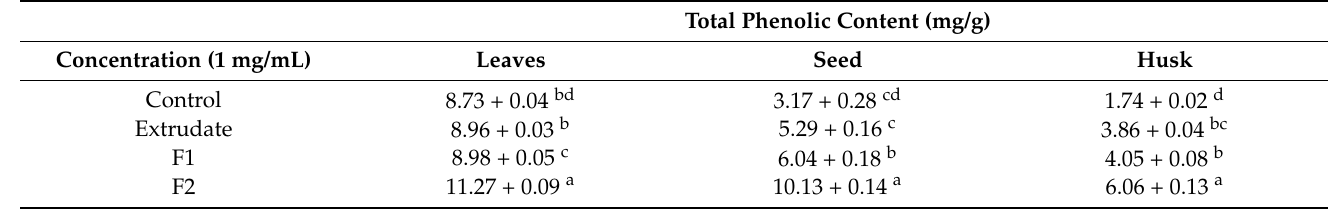
Table 2. Total phenolic contents of the control, extrudate, F1 and F2 formulation of M. oleifera (leaves, seed, and husk).